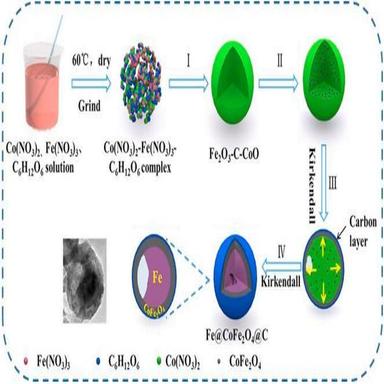
The schematic illustration of the preparation of Fe@CoFe2O4@C nanoparticles.